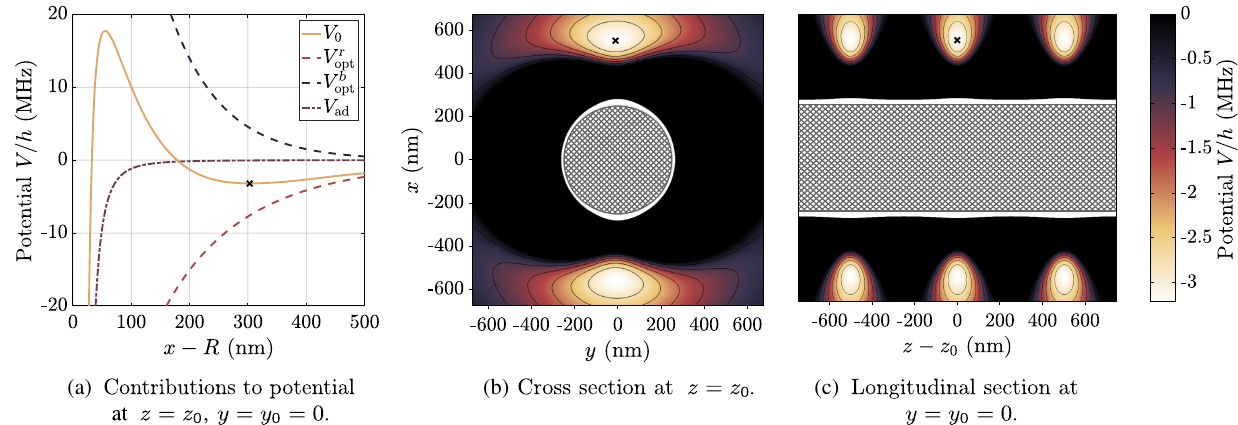
FIG. 4. Total potential experienced by the atom, with a trap minimum r 0 indicated by the cross. Panel (a) shows the different contributions to the total potential V 0 . Panels (b) and (c) show the total potential in a cross section and longitudinal section of the fiber, respectively. All positive values of the potential in (b) and (c) are shown as black. The parameters used for this plot are listed in Appendix